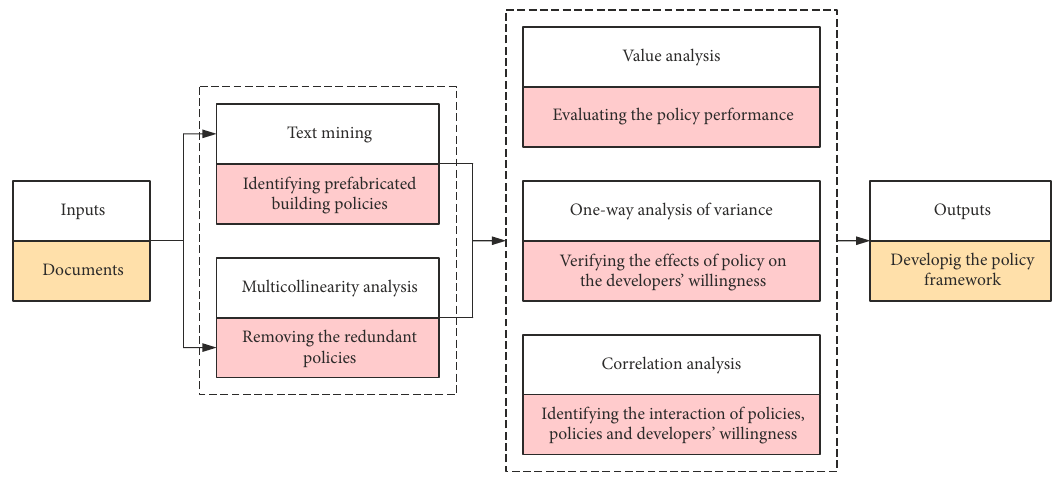
Figure 1. Research